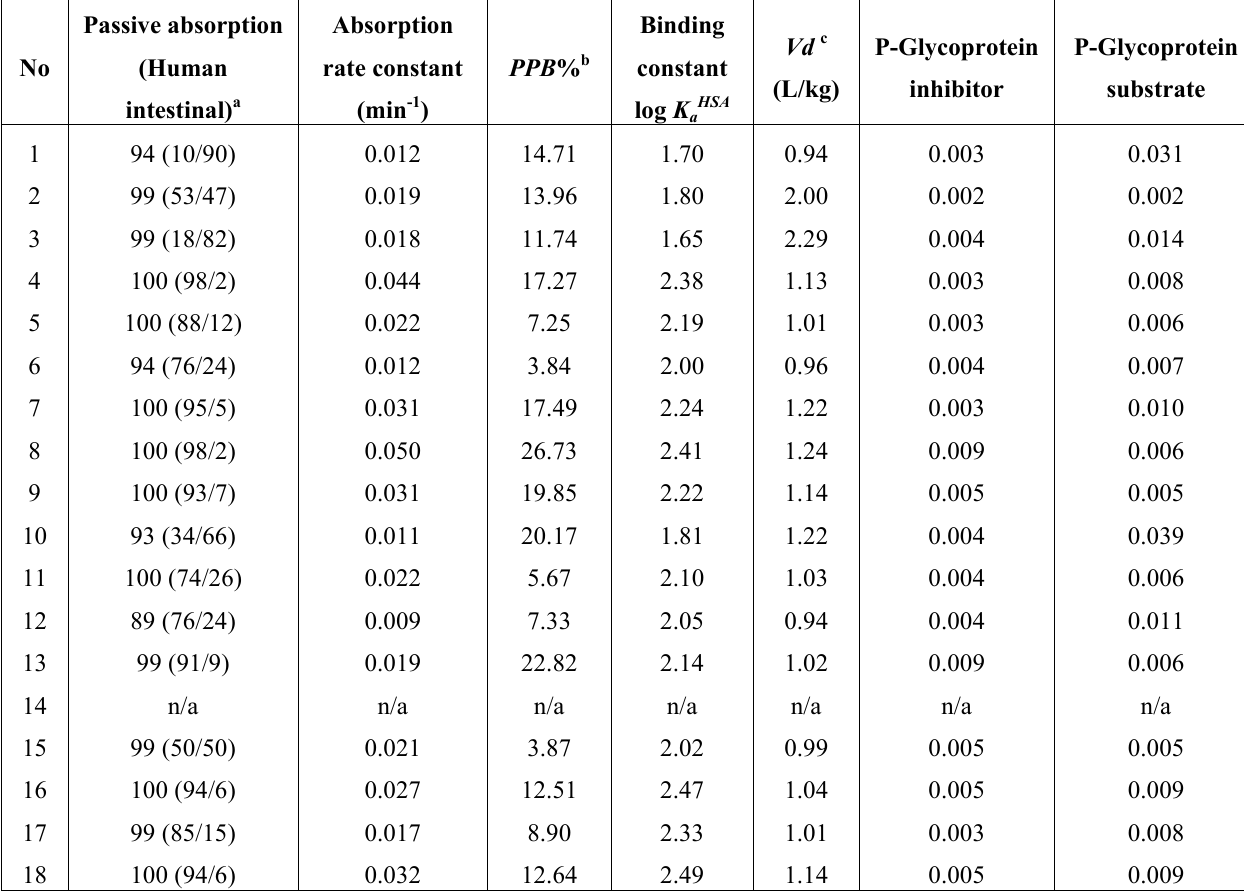
Table 4 . ADME results (n/a: calculations not available)